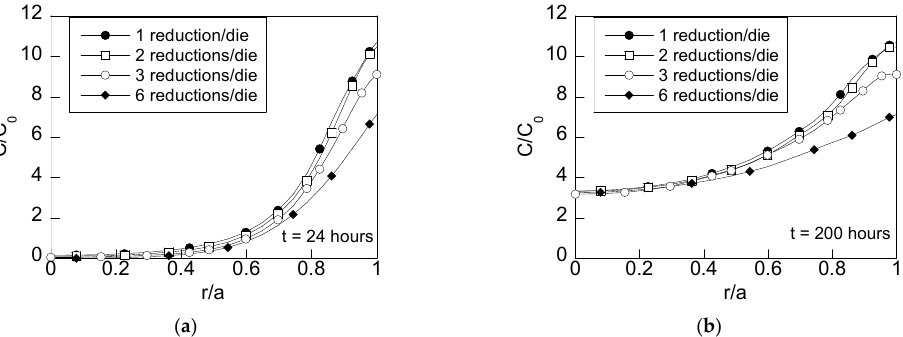
Figure 8. Radial distributions of relative concentrations of hydrogen ( C / C 0 ) as a function of the dimensionless radial coordinate r / a , at two different diffusion times: ( a ) t = 24 h and ( b ) 200 h.